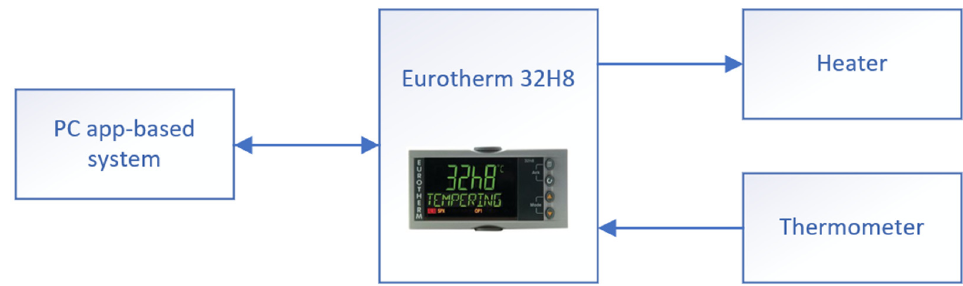
Figure 8. Temperature controller connection.